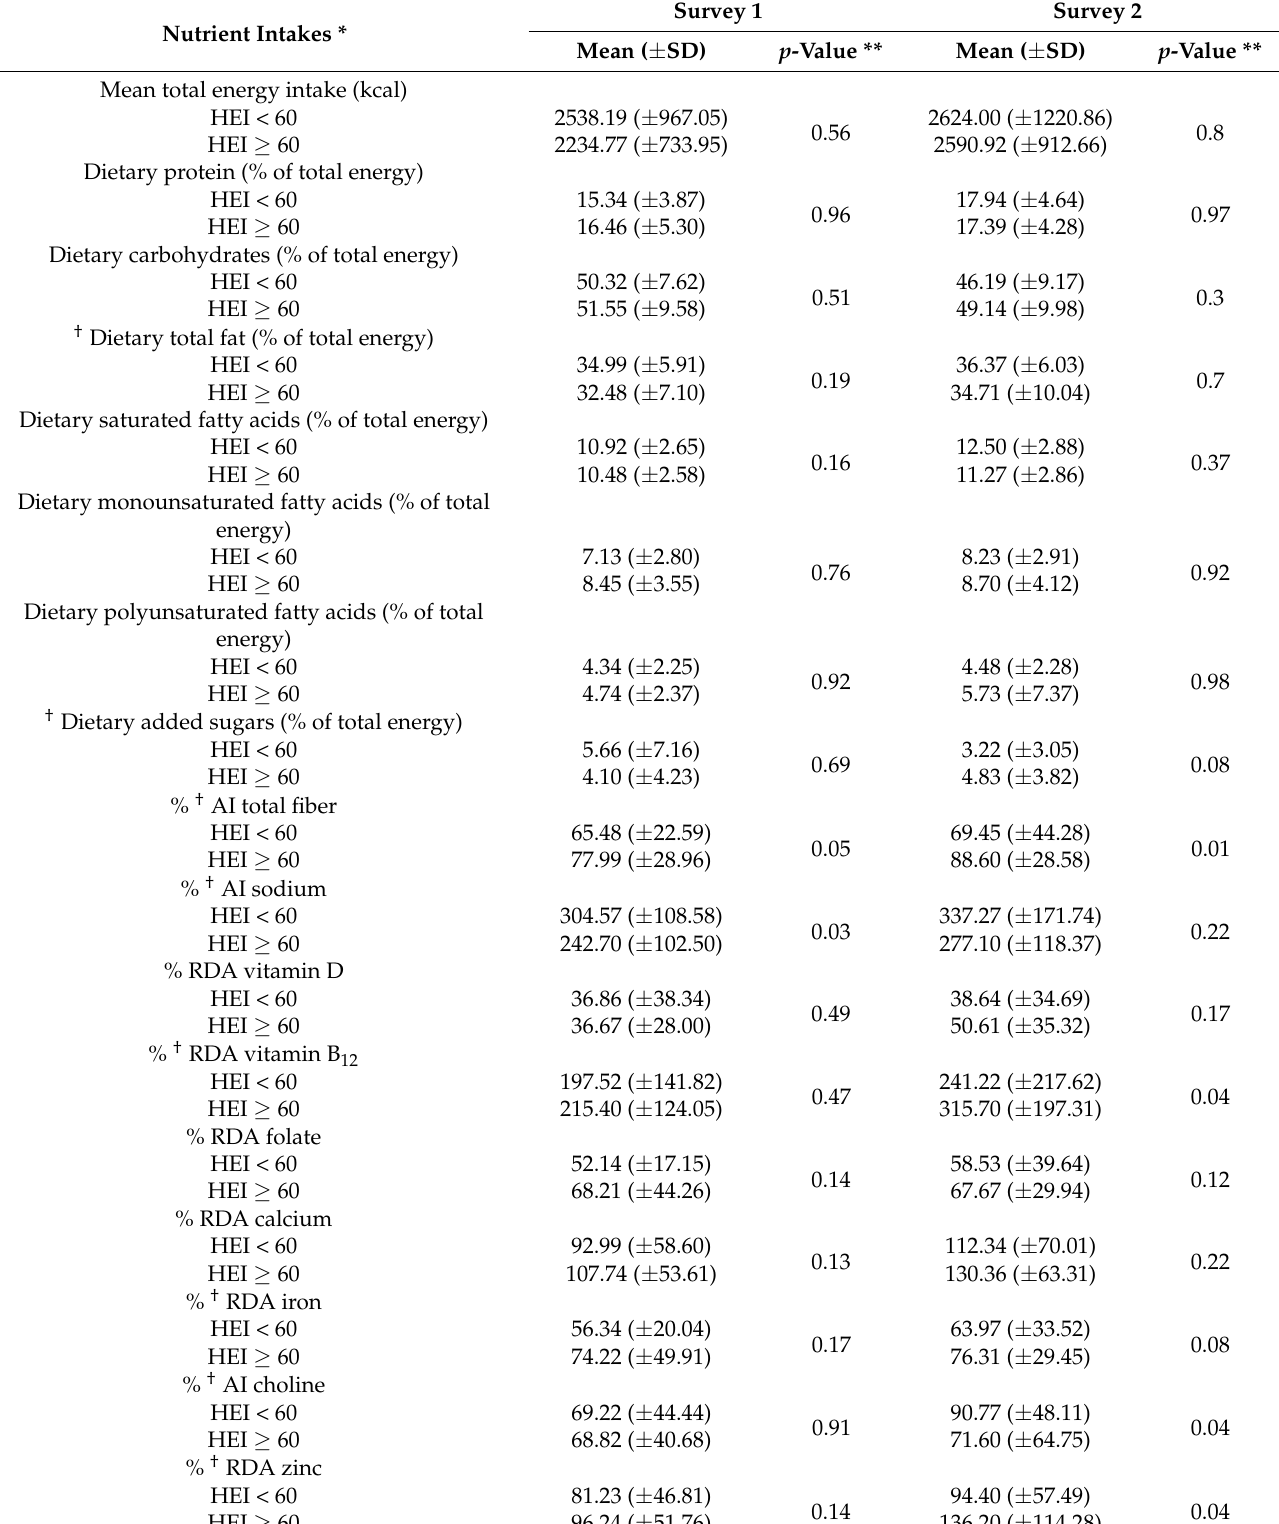
Table 5. Percentage of recommended nutrient intakes of participants in the two HEI categories for survey 1 and survey